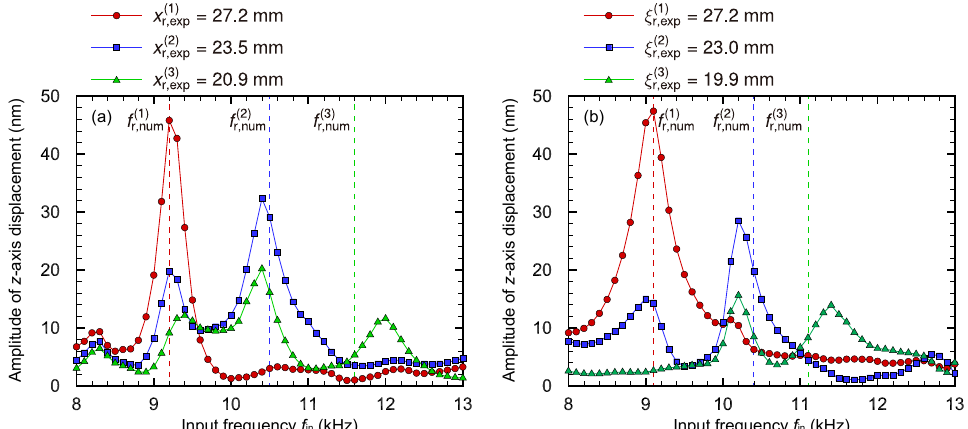
Figure 7. Experimentally obtained resonance characteristics at each resonance position of ( a ) the trapezoidal and ( b ) curved membrane devices. A frequency is observed at which the amplitude is maximized, and this frequency is defined as the resonance frequency based on the experimental results. The dashed line indicates the resonance frequencies obtained via the numerical analysis. Both devices’ experimental and numerical results are in good agreement. Tables 1 and 2 indicate that the resonance frequencies for the trapezoidal and curved membrane devices are almost the